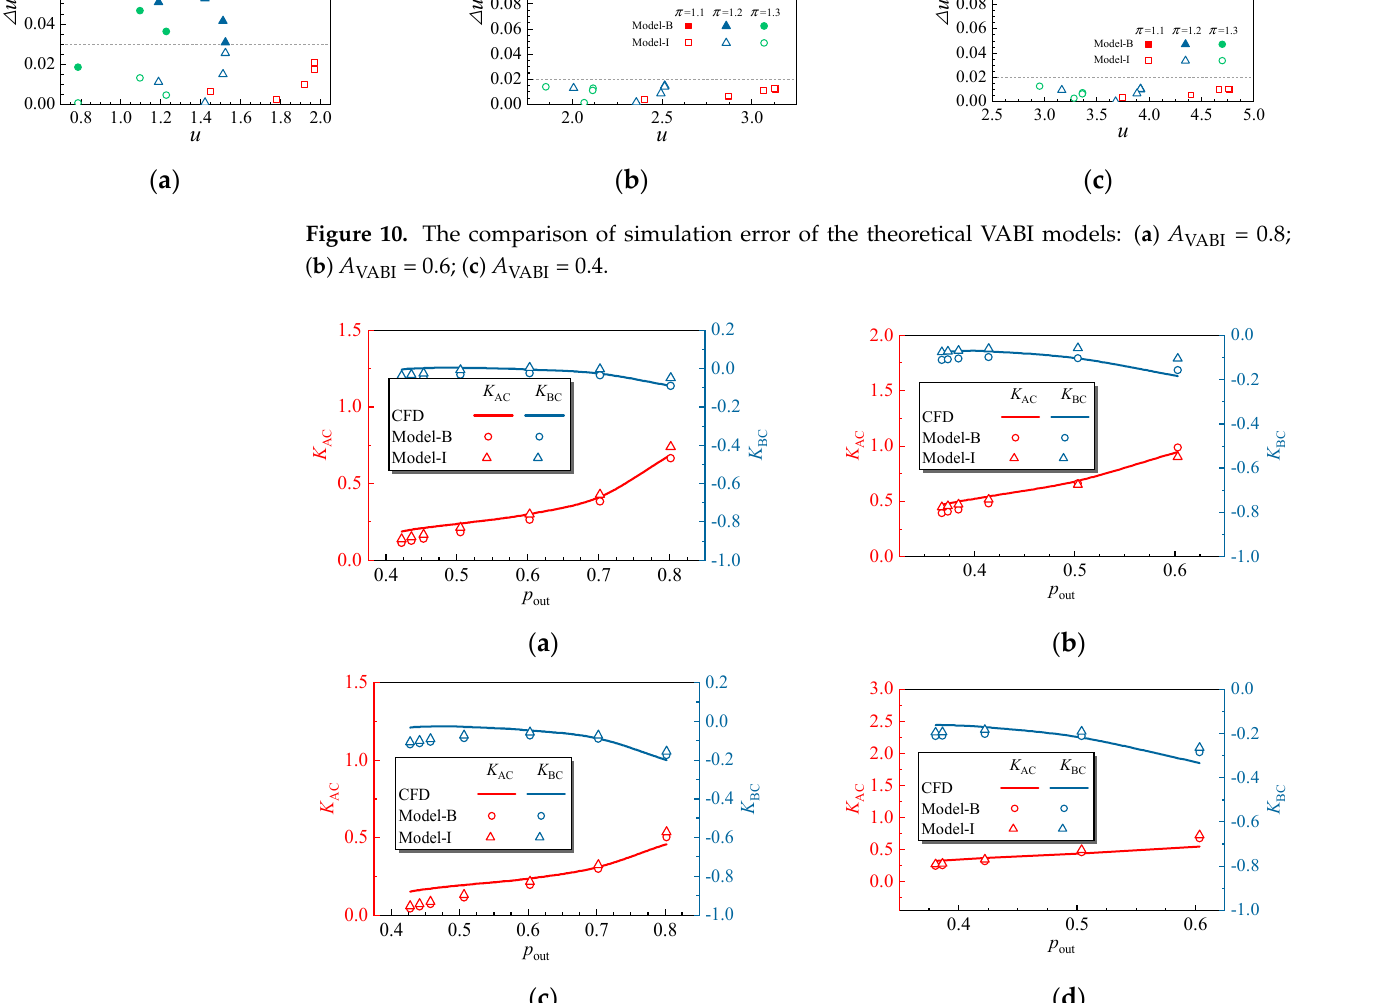
Figure 11. The comparison of the VABI loss characteristics: ( a ) A VABI = 0.4, π = 1.1; ( b ) A VABI = 0.4, π = 1.3; ( c ) A VABI = 0.8, π = 1.1; ( d ) A VABI = 0.8, π = 1.3.